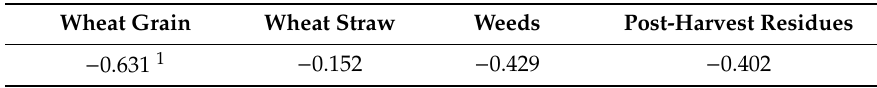
Table 10. Relationship between P content and biomass volume of plant biomass parts—simple correlation coe ffi cients.